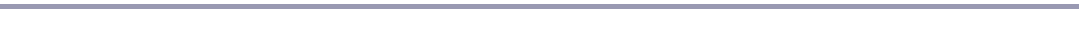
Fig. 1. Habitat configuration, observed home ranges, and study area boundaries located 200 km northwest of Lac Saint-Jean, Quebec, Canada. The study-area boundaries were determined by creating a 4-km buffer zone (1 km playback carrying distance plus 3 km potential bird displacement) on both sides of the roads traveled during capture operations (different in 2005 and